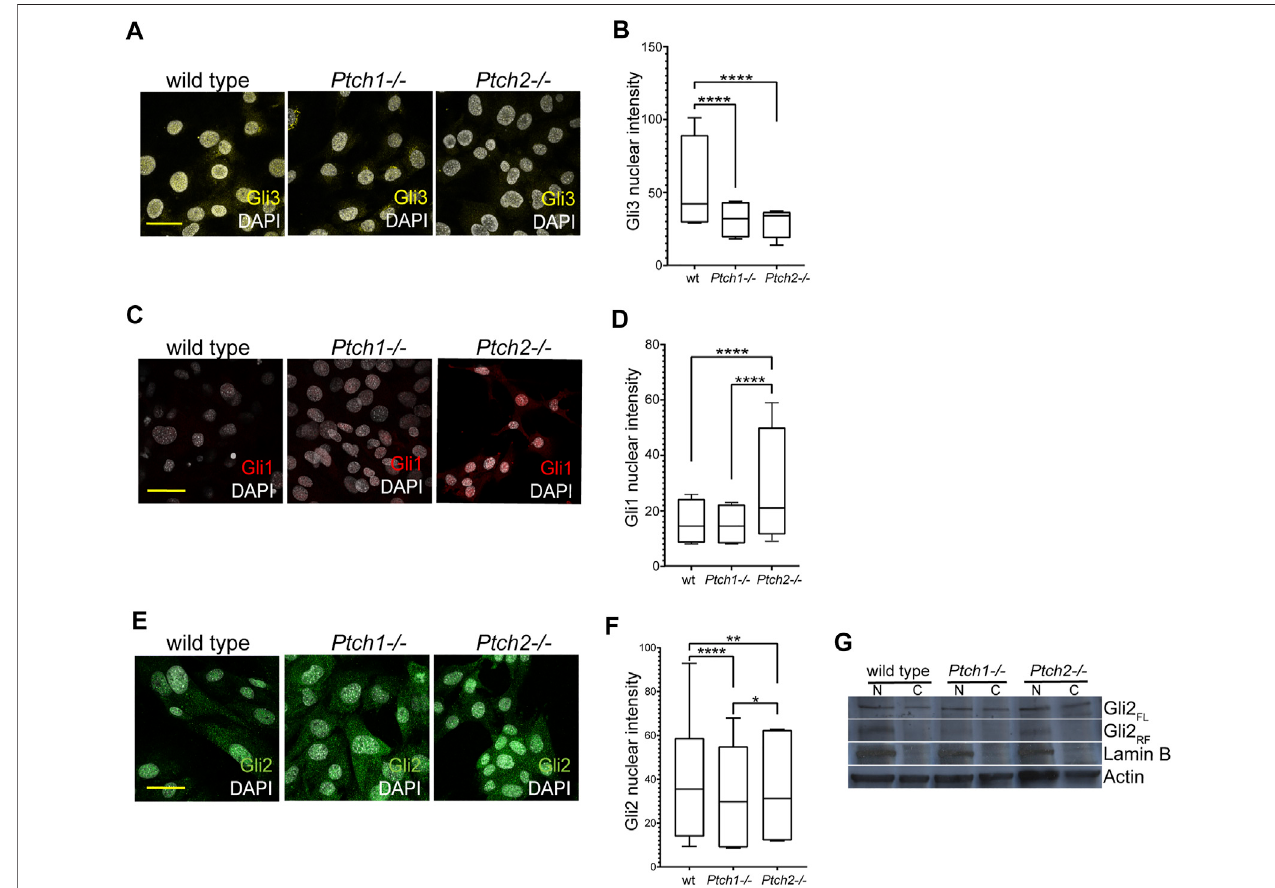
FIGURE 4 | Analysis of Ptch receptor-dependent inhibition of Hh signaling. (A,C,E) Immunocytochemistry detection of Gli3 (A) , Gli1 (C) and Gli2 (E) in the wild- type, Ptch1 − / − , and Ptch2 − / − MEFs. Scale bar 50 μ m. (B,D,F) Quanti fi cation of the intensity of the nuclear GLI3 (B) , GLI1 (D) , and GLI2 (F) in wild-type, Ptch1 − / − , and Ptch2 − / − MEFs. ** p ≤ 0.005, *** p ≤ 0.0005, **** p < 0.0001. (G) Western blot showing nuclear (N) and cellular (C) expression of Gli2 (FL = full length and RF = repressor form) in wild-type, Ptch1 − / − and Ptch2 − / − MEFs.